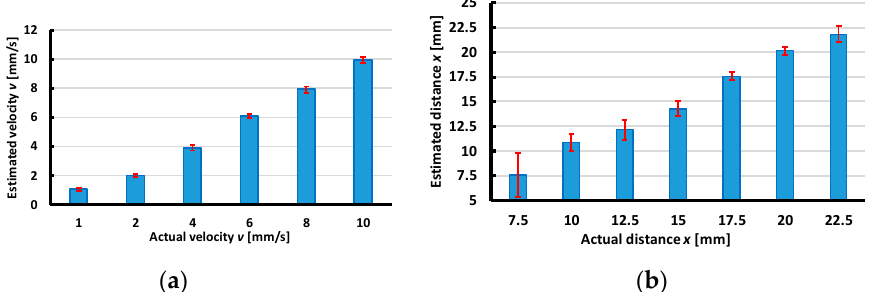
Figure 22. Calculated results compared to actual values with Y-sliding case. ( a ) Comparison of calculated and actual velocity. ( b ) Comparison of calculated and actual distance x (mm).